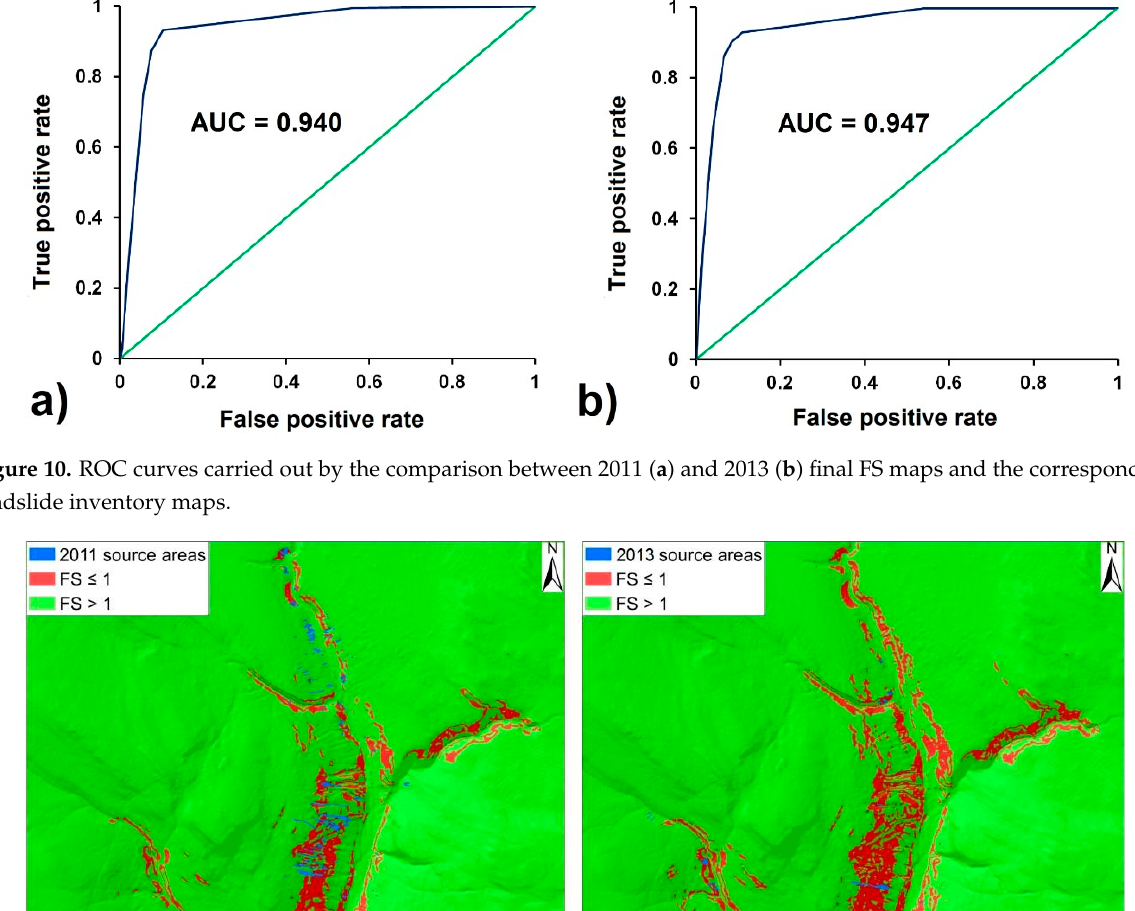
Table 5. Number of correct and false predictions resulting from TRIGRS simulations for the 2013 event.